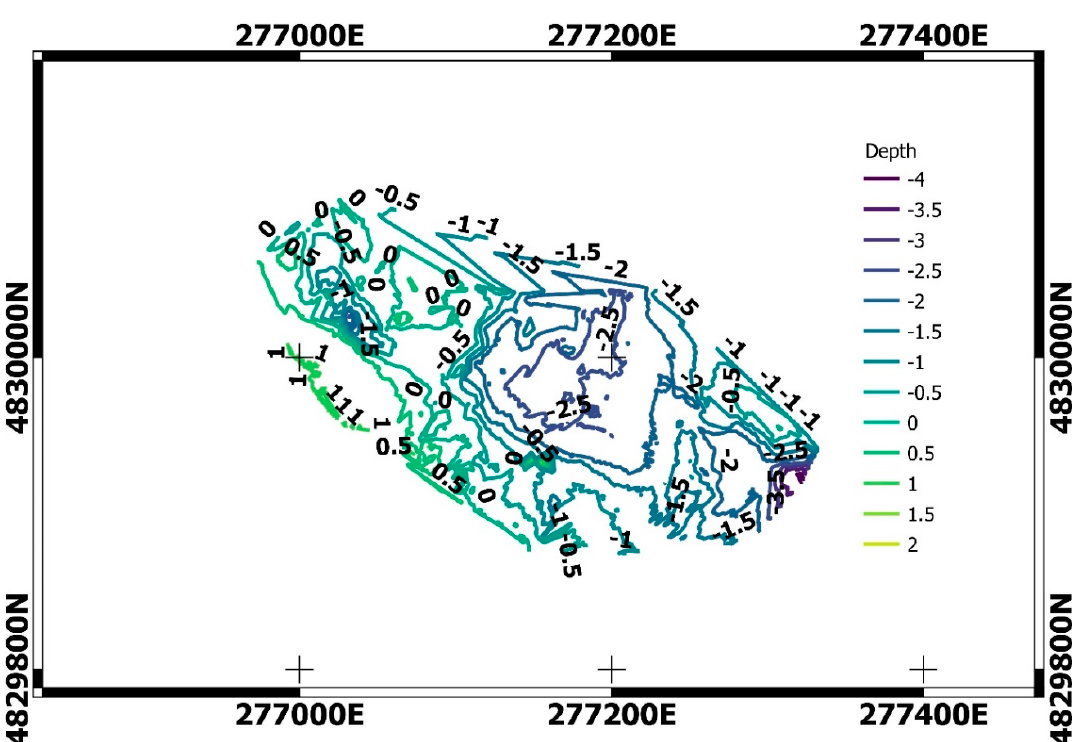
Figure 6. Water depth map obtained using echo sounder measurements in Candás. The color indicates the depth in meters.